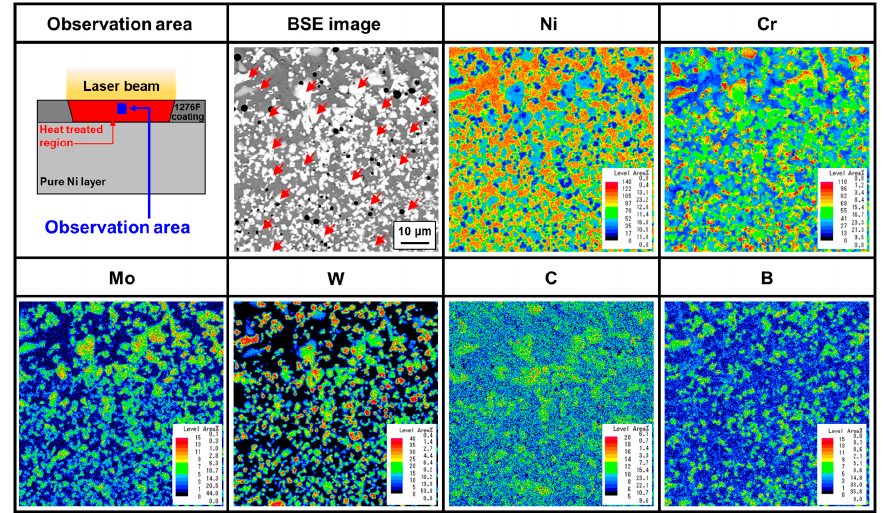
Figure 7. Electron probe X-ray micro analyzer (EPMA) analysis of thermal-sprayed layers after laser-assisted fusing treatment of 1276F coating at 1473 K (red-colored arrows in BSE image indicate secondary phases).